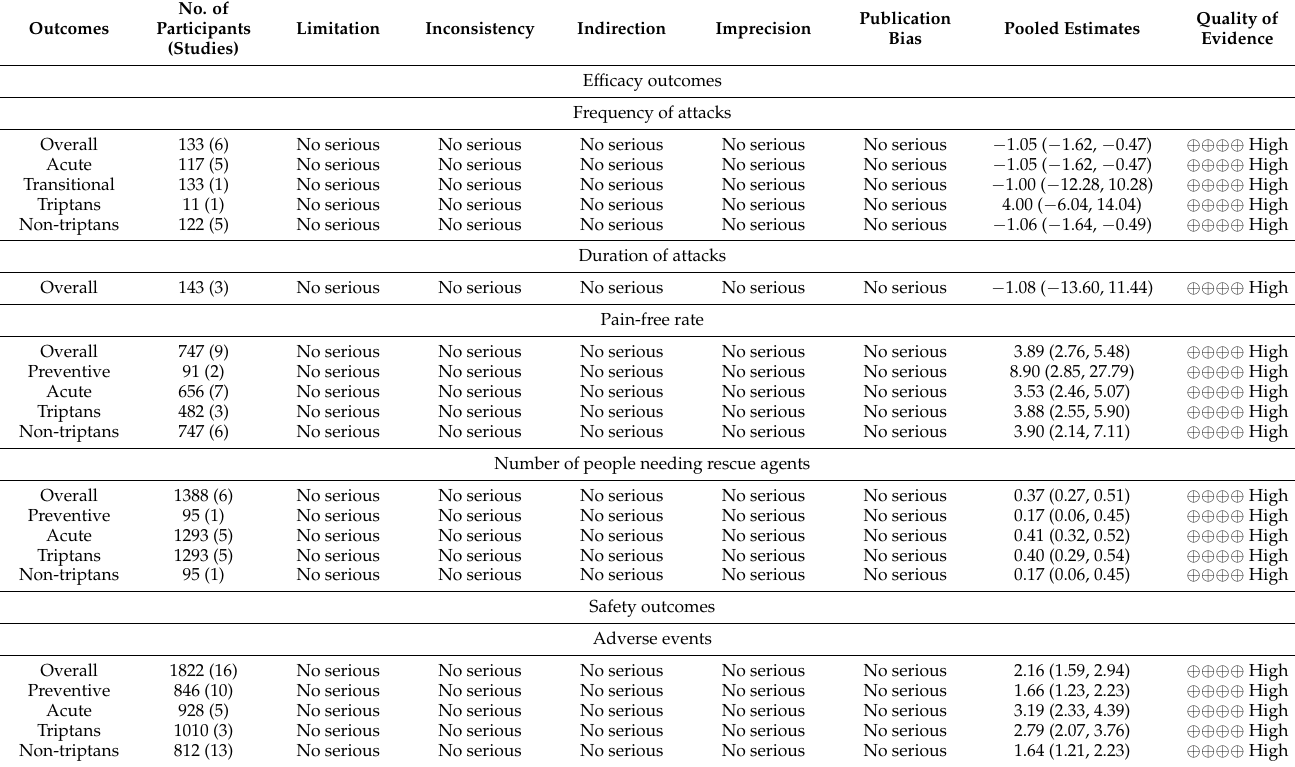
Figure 11. Publication bias of the studies analyzed. Table 3. Summary of findings for efficacy and safety outcomes comparing interventions to compara- tors based on the GRADE approach.